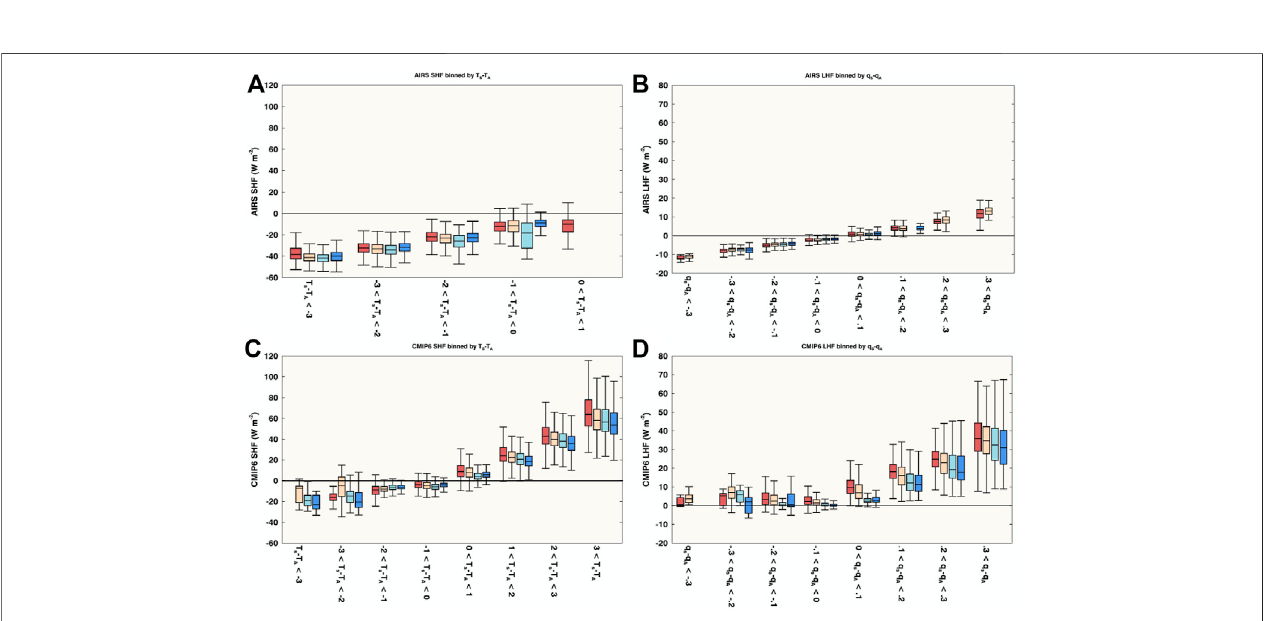
FIGURE 6 | Winter (ONDJ) decadal trends for CMIP6 for (A) T S , (B) T A , (C) I C , (D) SHF and (E) LHF, and the across model spread for (F) T S , (G) T A , (H) I C , (I) SHF and (J) LHF.